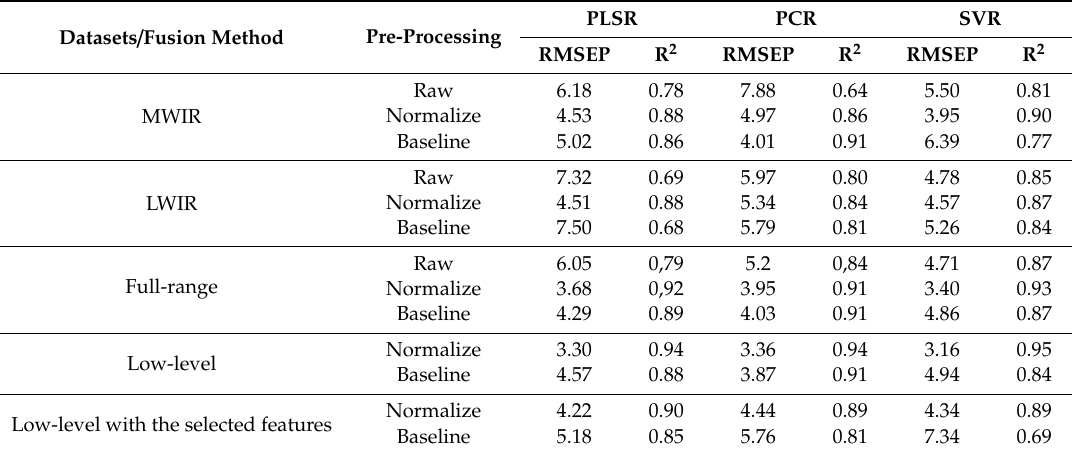
Table 1. Statistical summary of the partial-least squares regression (PLSR), principal component regression (PCR), and SVR models for the prediction of Fe 2 O 3 . The concentrations of Fe 2 O 3 in the analysed samples were in the range of 3.03 − 59.9 wt%.